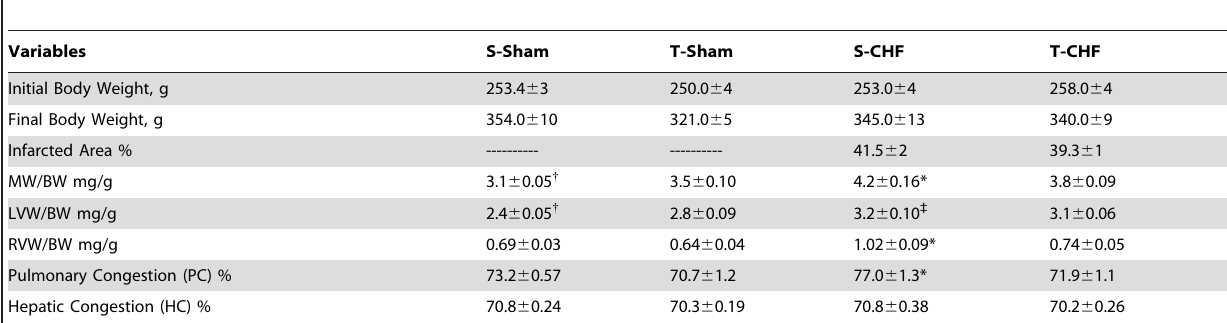
Table 1. Body weight, morphometric cardiac characteristics, infarct area and pulmonary and hepatic congestion of sham-operated rats and rats with left ventricular dysfunction.